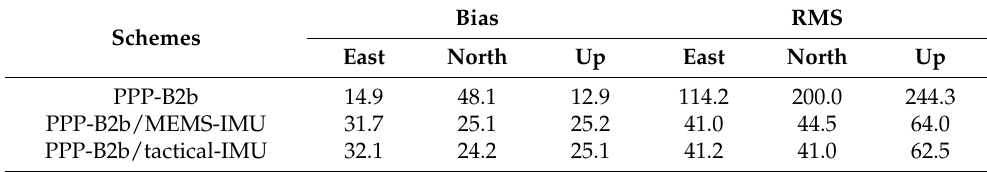
Figure 10. Two bridge scenarios during the period from 09:35:00 to 09:49:59. Table 5. The positioning accuracy during the period from 09:35:00 to 09:49:59 (unit: